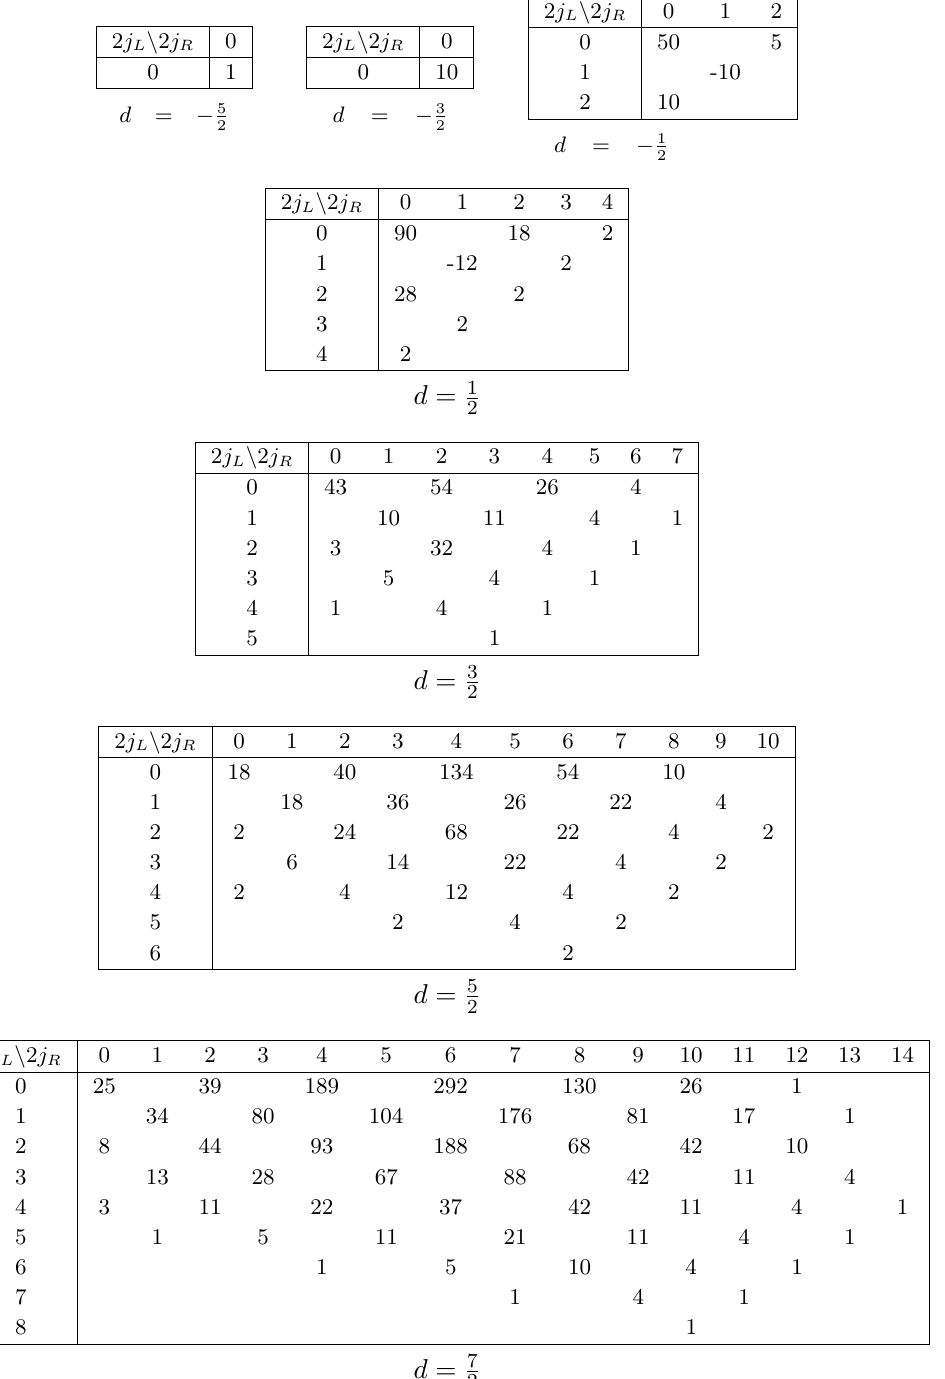
Table 14 . Pseudo-BPS spectrum of Wilson loop for local P 1 × P 1 in the representation 2 ⊗ 5 of SU(2) for the curve class dt = 2 dφ